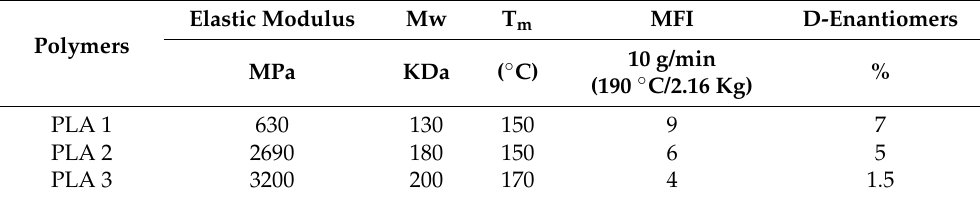
Table 1. General properties of the PLA used in this study.